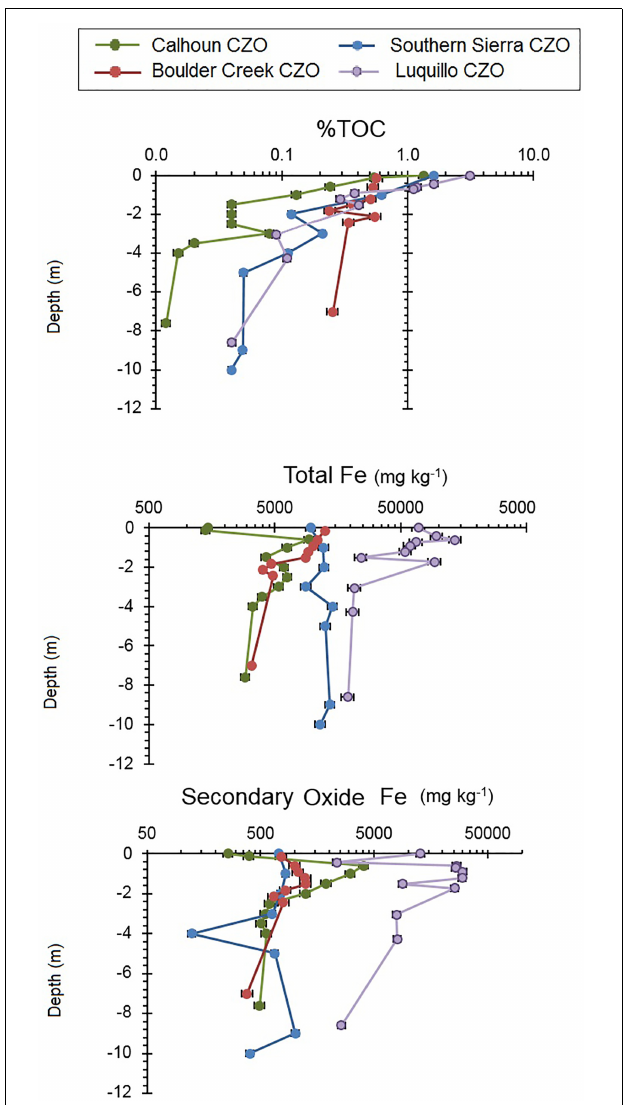
FIGURE 2 | Regolith profiles of Mo, V, and Cr concentrations in total digests and two extractions of secondary Fe oxide bound (citrate–bicarbonate–dithionate) and organic + amorphous oxide bound at the four CZOs. Error bars are coefficients of variation for each measurement. Please note each scale is different for each phase